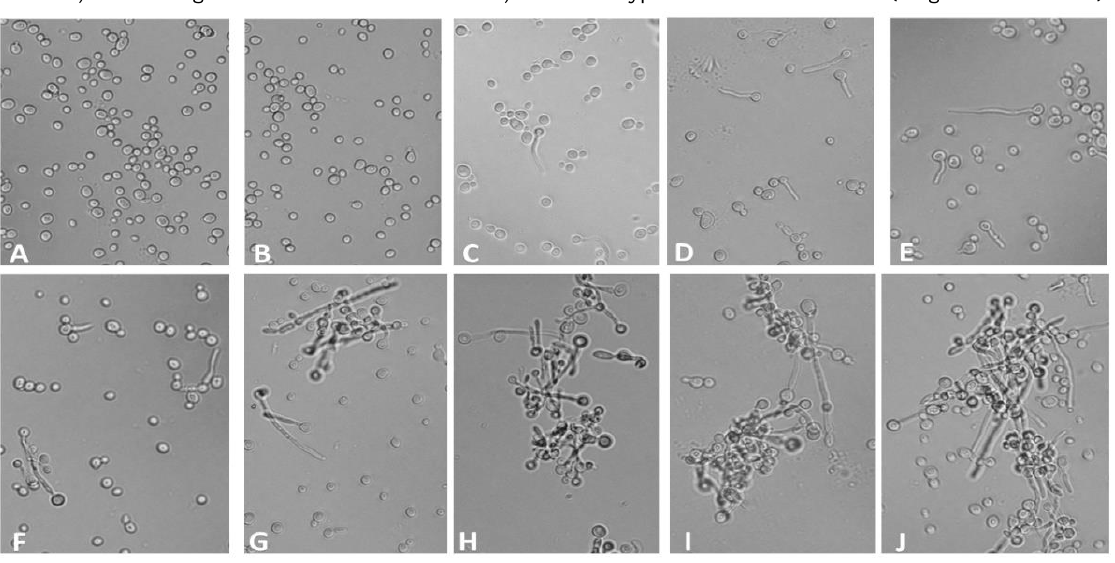
Figure 1. Wet mount preparations for the growth forms of tested Candida albicans strains. A&B, yeast forms (blastospores) showing round to oval cells with budding. C-J, germinated and hyphal forms after incubation in 10% (vol/vol) fetal bovine serum in phosphate buffered saline for different time periods, maximum for 200